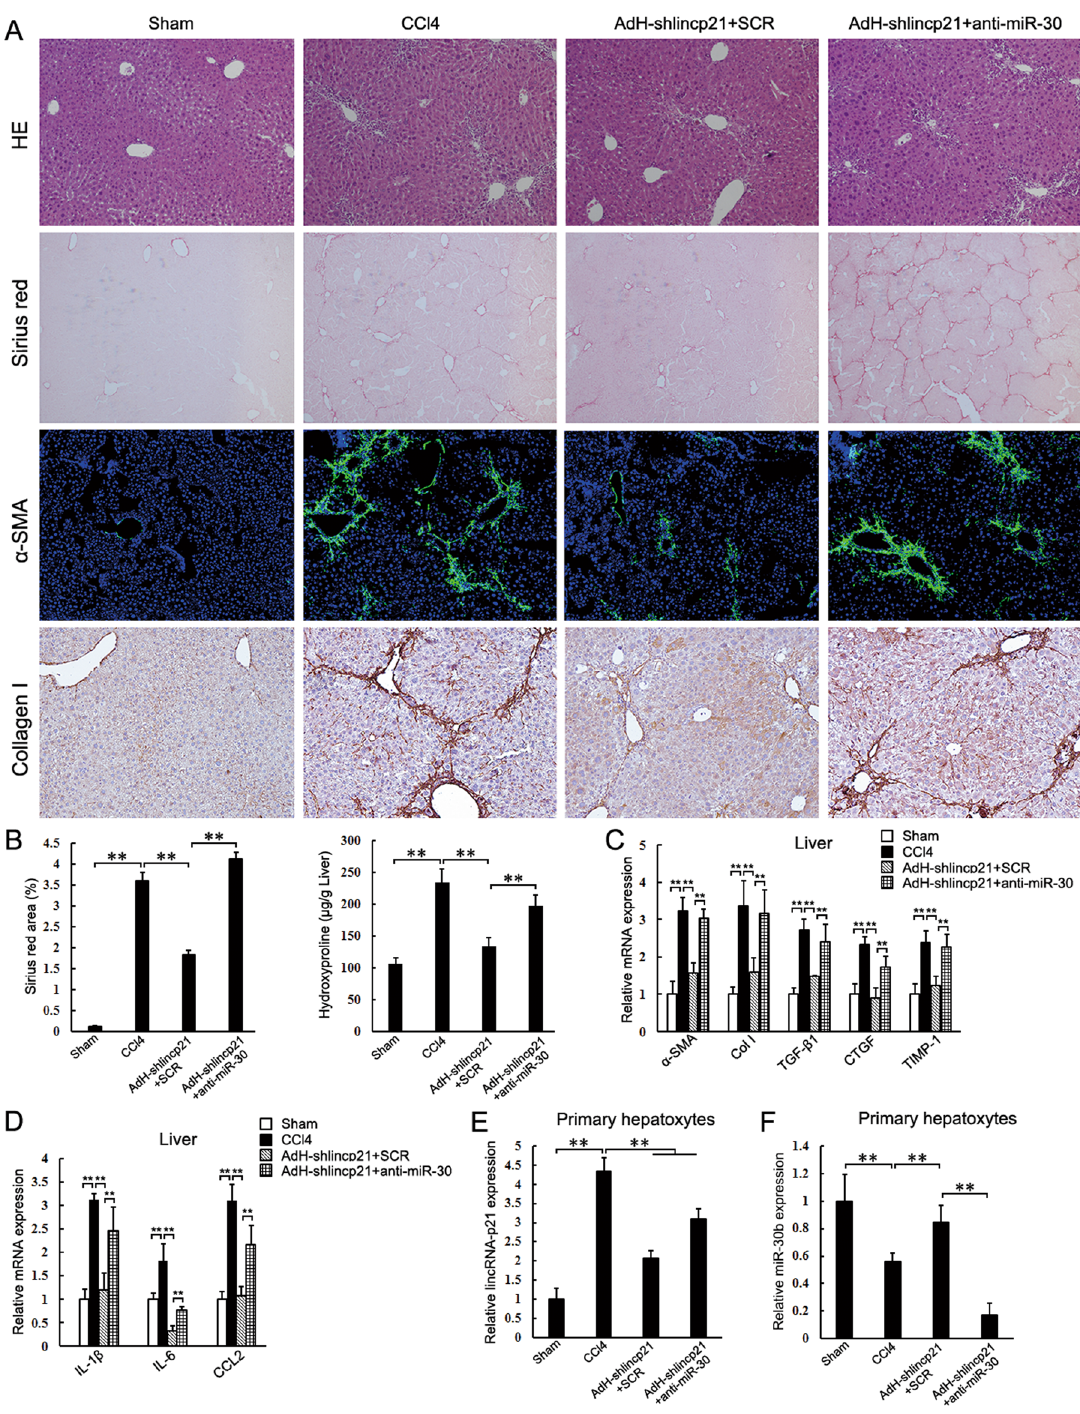
Figure 5. Inhibition of miR-30 impairs the effects of lincRNA-p21 knockdown on CCl 4 -induced liver fibrosis. Mice were treated with oil (Sham, n = 6), CCl 4 (CCl4, n = 6), CCl 4 in combination with injection of AdH-shlincp21 and SCR (AdH-shlincp21 + SCR, n = 6) and CCl 4 in combination with injection of AdH-shlincp21 and anti- miR-30 (AdH-shlincp21 + anti-miR-30, n = 6). The mice were sacrificed after 3 weeks CCl 4 treatment. ( A ) Liver fibrosis was evaluated by H&E staining (100 × ), sirius red staining (40 × ), α -SMA immunofluorescence staining (100 × ) and collagen I immunohistochemical staining (100 × ). ( B ) Quantifications of the sirius red positive area and hepatic hydroxyproline content. The hydroxyproline contents are expressed as μ g/g wet liver weight. ( C ) Hepatic α -SMA, collagen I, TGF- β 1, TIMP-1 and CTGF mRNA were determined by qRT-PCR. ( D ) Hepatic IL-6, IL-1 β and CCL2 mRNA were determined by qRT-PCR. ( E and F ) lincRNA-p21 and miR-30b levels in the isolated hepatocytes were determined by qRT-PCR respectively. The results are shown as fold change compared with Sham group mice. Data are the mean ± SEM of three independent experiments. * P < 0.05, ** P <